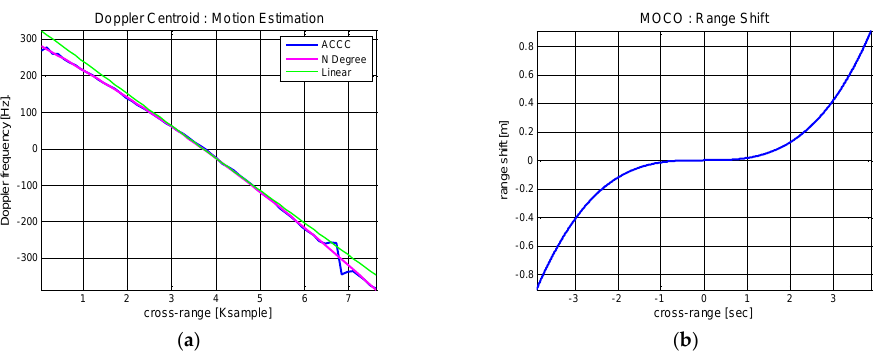
Figure 17. Range error estimation based Doppler history analysis: ( a ) Polynomial fitting results; ( b ) Range shift error calculation.